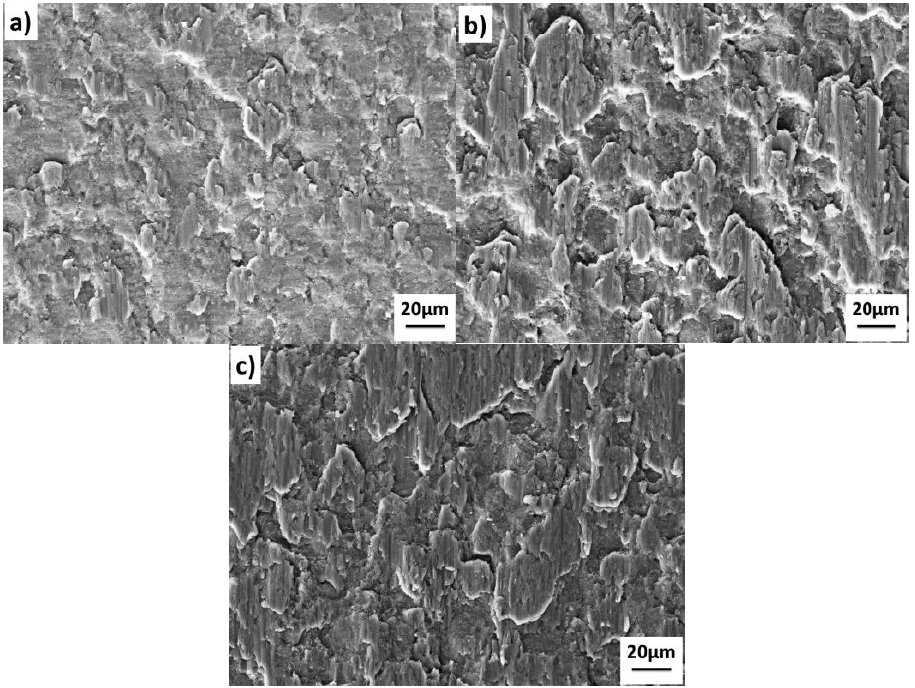
Figure 6. Shear test fractographs of the 7B04-7B04 joints after bonded at different temperatures: ( a ) 460 °C; ( b ) 490 °C; ( c ) 520 °C.